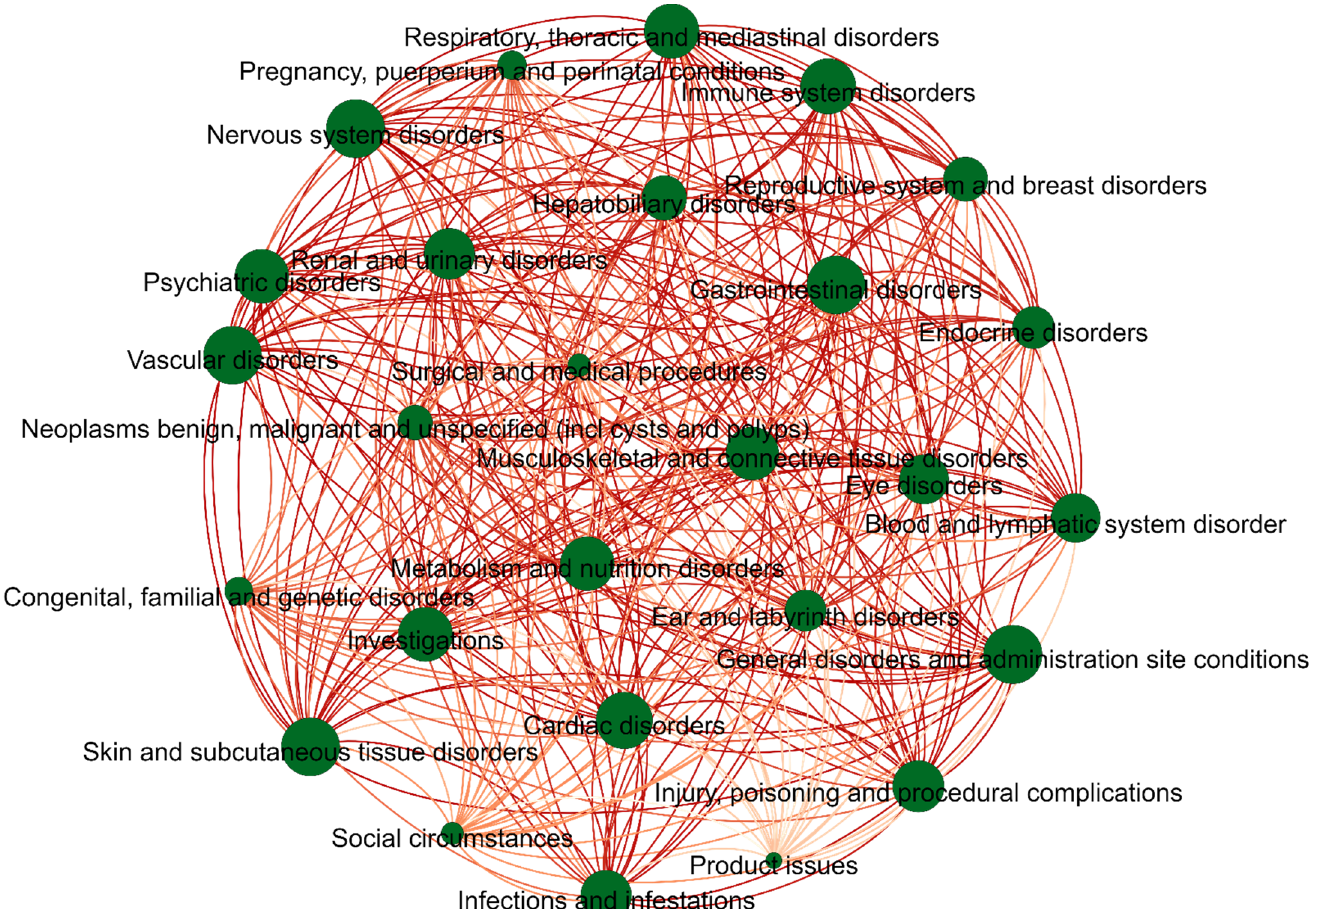
Figure 6. Label co-occurrence diagram, referring to the simultaneous occurrence of two labels; the green circle represents the label, and the size of the circle is the frequency of that ADR label; the red line connecting the two circles represents the simultaneous occurrence of these two ADR labels; the color shade of the edges indicates the number of times this group of labels appears; the darker the color, the more often this group of labels appears.